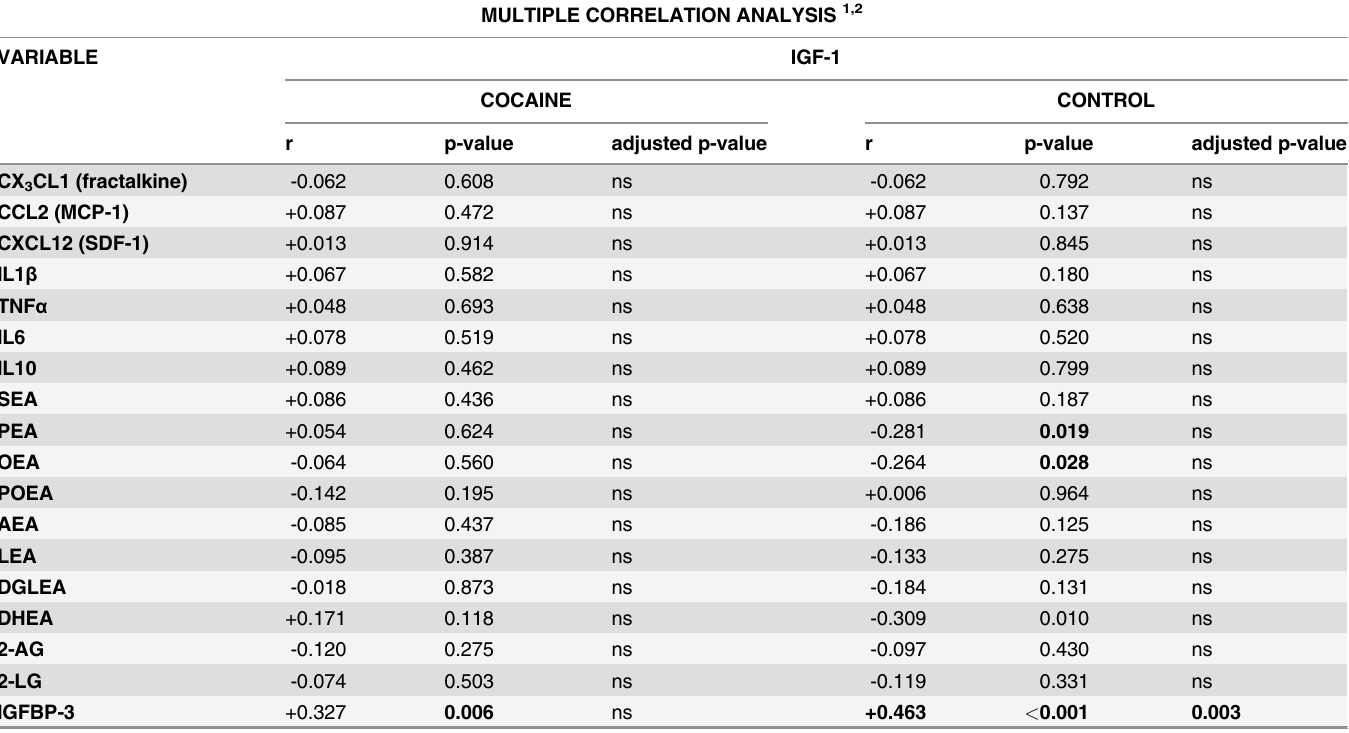
Table 3. Multiple correlations between plasma concentrations of IGF-1 and other plasma molecules in the cocaine